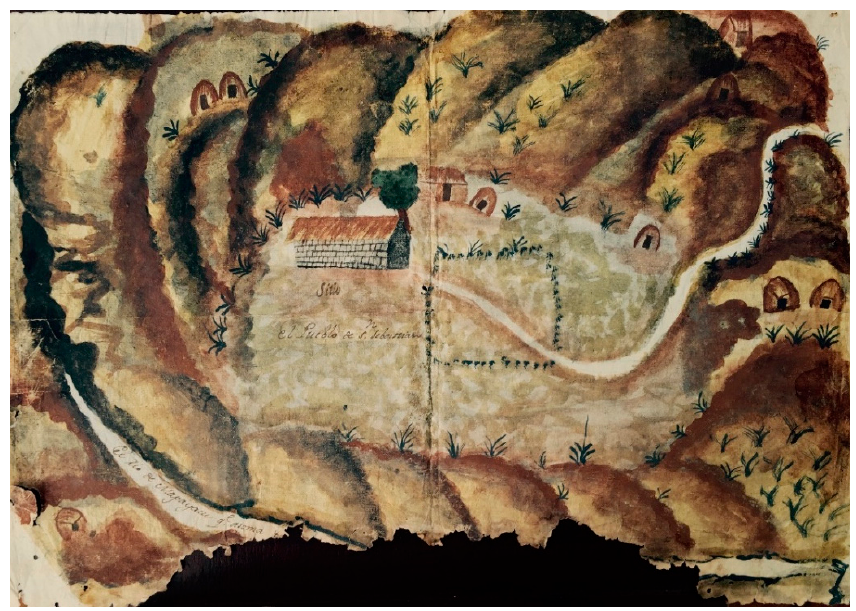
Figure 4. Map of San Sebastián, Latacunga; watercolor on paper; 1798; Archivo Nacional de